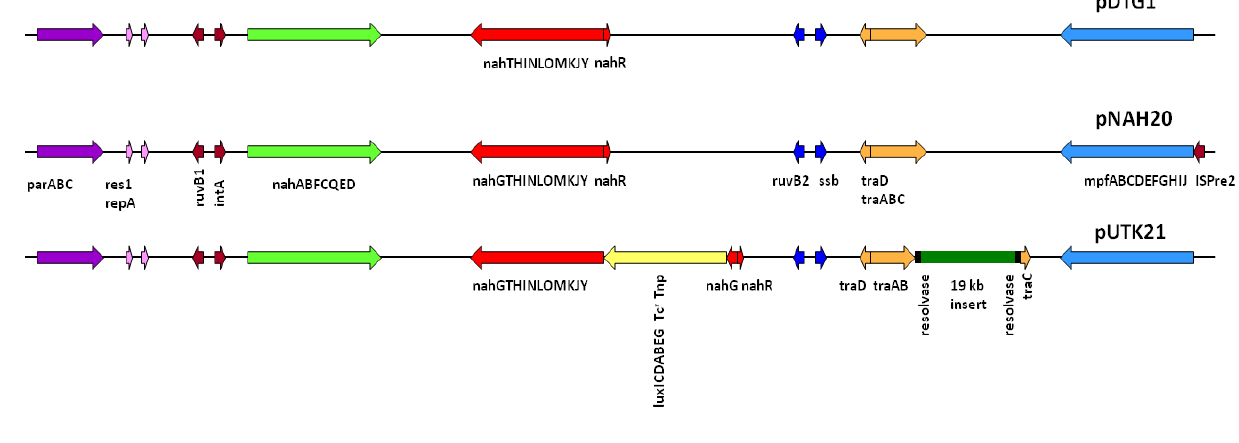
Figure 4. Physical organization of the gene clusters in three plasmids pDTG1, pNAH20, and pUTK21 belonging to Pseudomonas strains. Genes of the same color indicate corresponding orthologous genes with high homology (>80%) at the nucleic acid level and arrows indicate direction of transcription (Adapted from